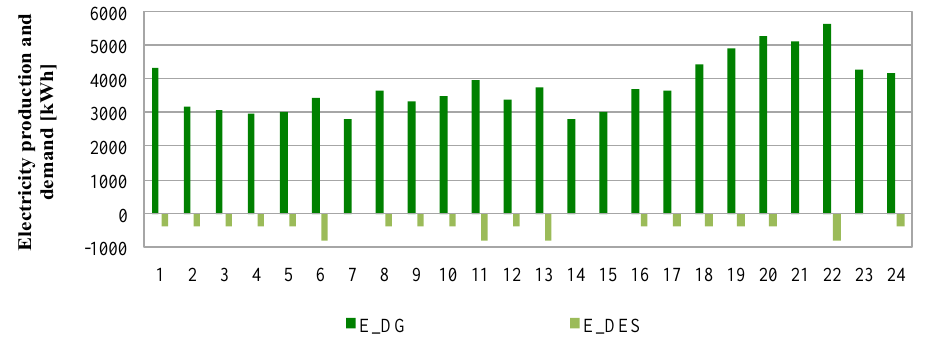
Figure 9. Optimal daily schedule of diesel generators and desalination units in May (minimum load month) in the TO-BE scenario 1. In this figure E_DG is the variable E DG and E_DES is the variable E DES.